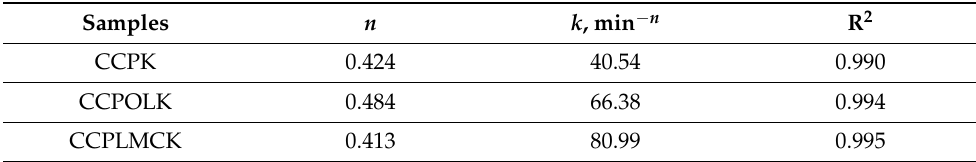
Table 4. Kinetic parameters of the drug release from investigated samples.